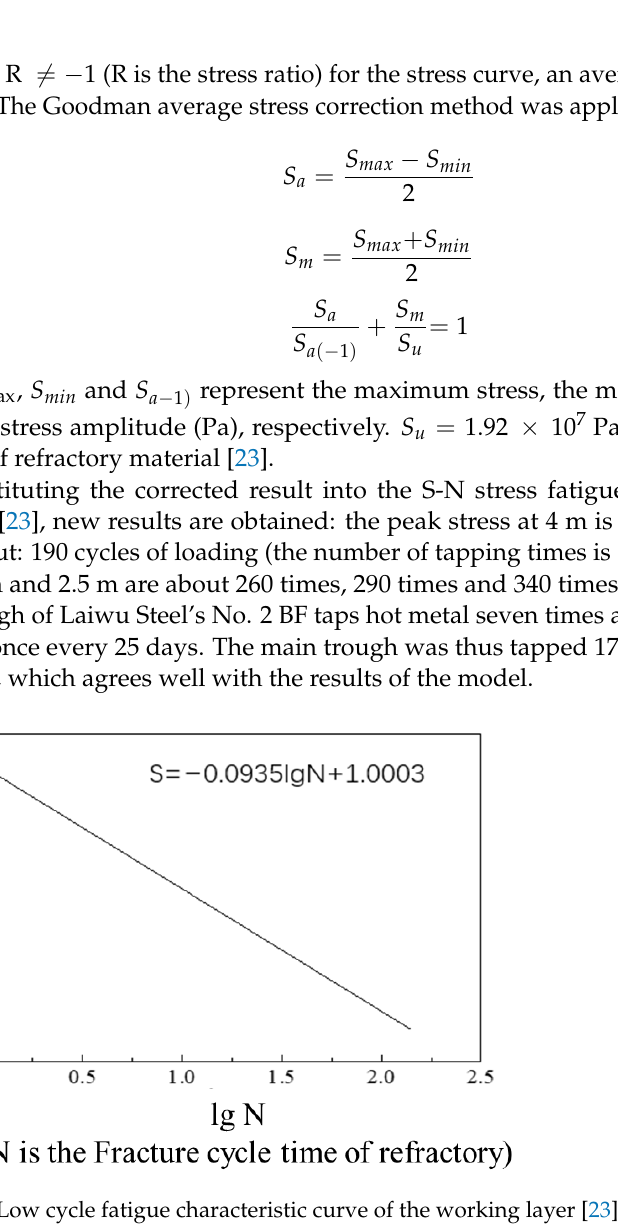
Table 3. Size of the baffles that suppress turbulence.